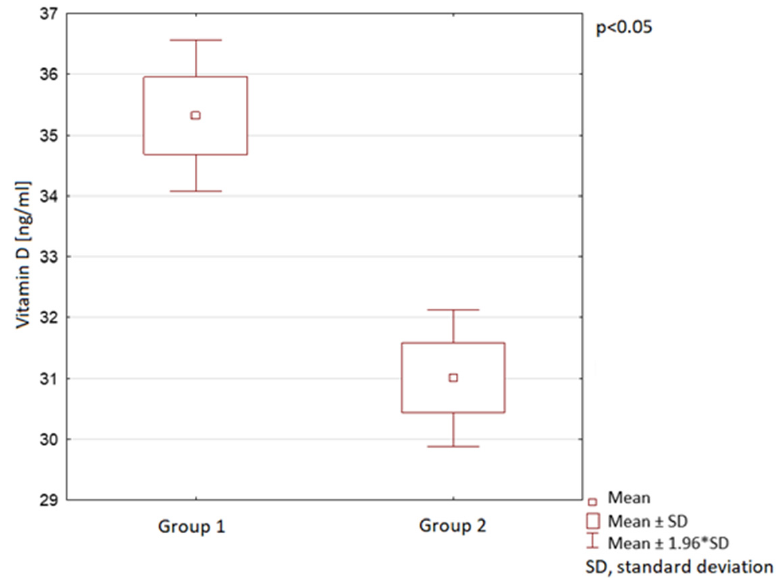
Figure 4. Vitamin D serum levels in children in the compared groups. serum levels was observed, however, a lower than in the general paediatric population analysed above (Figure 5). The mean vitamin D serum levels were 54 ng/mL ± 21 in Group 1 inf and 47 ng/mL ± 15 in the Group 2 inf. In both infant groups the mean vitamin D levels were within the normal range.